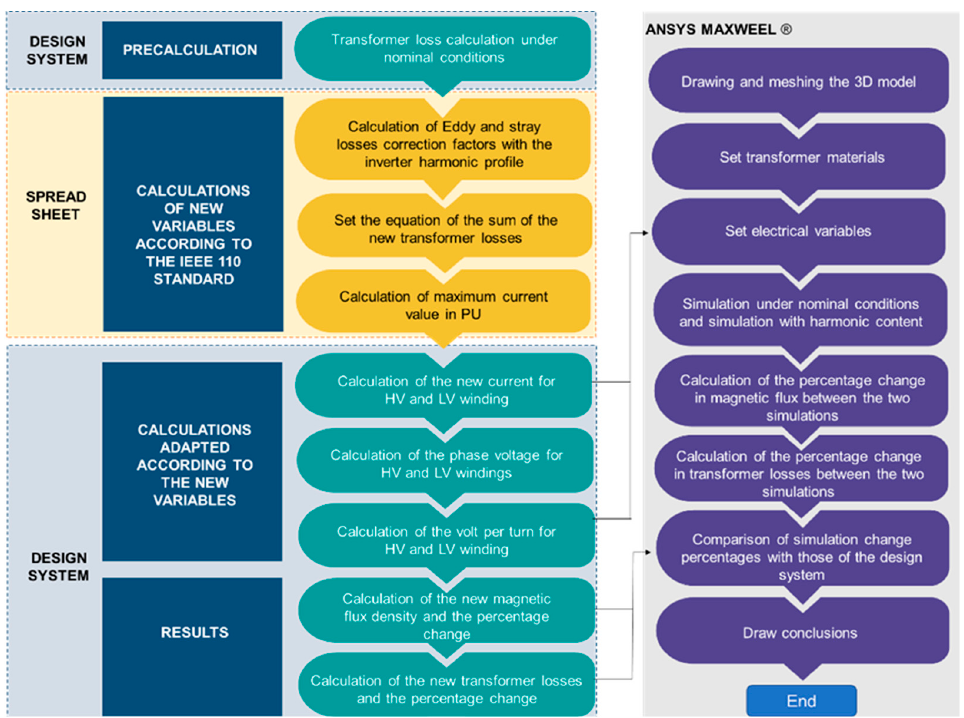
Figure 1. Proposed methodology for solar power plant (SPP) transformer design with a specific harmonic profile.